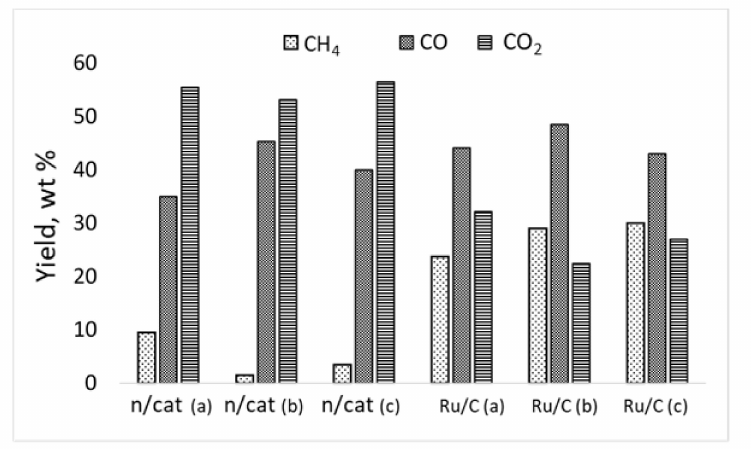
Figure 7. Composition of gaseous products of hydrogenation of the initial (a), alkali-pretreated (b) and acid-pretreated (c)